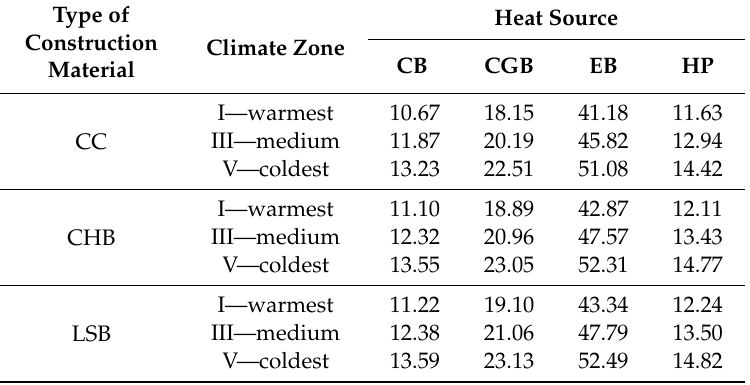
Table 4. Annual economic heating cost G o [(PLN · K) / (W · y)].